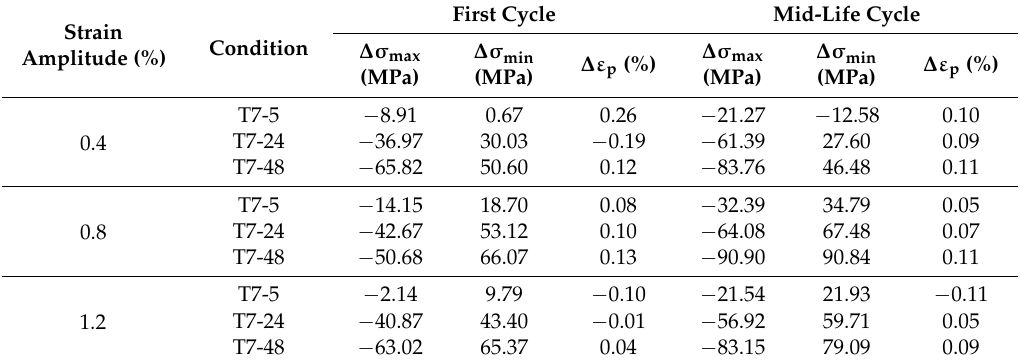
Table 3. Differences in peak stresses and plastic strain between T6 and various T7 conditions during the first and mid-life cycles.